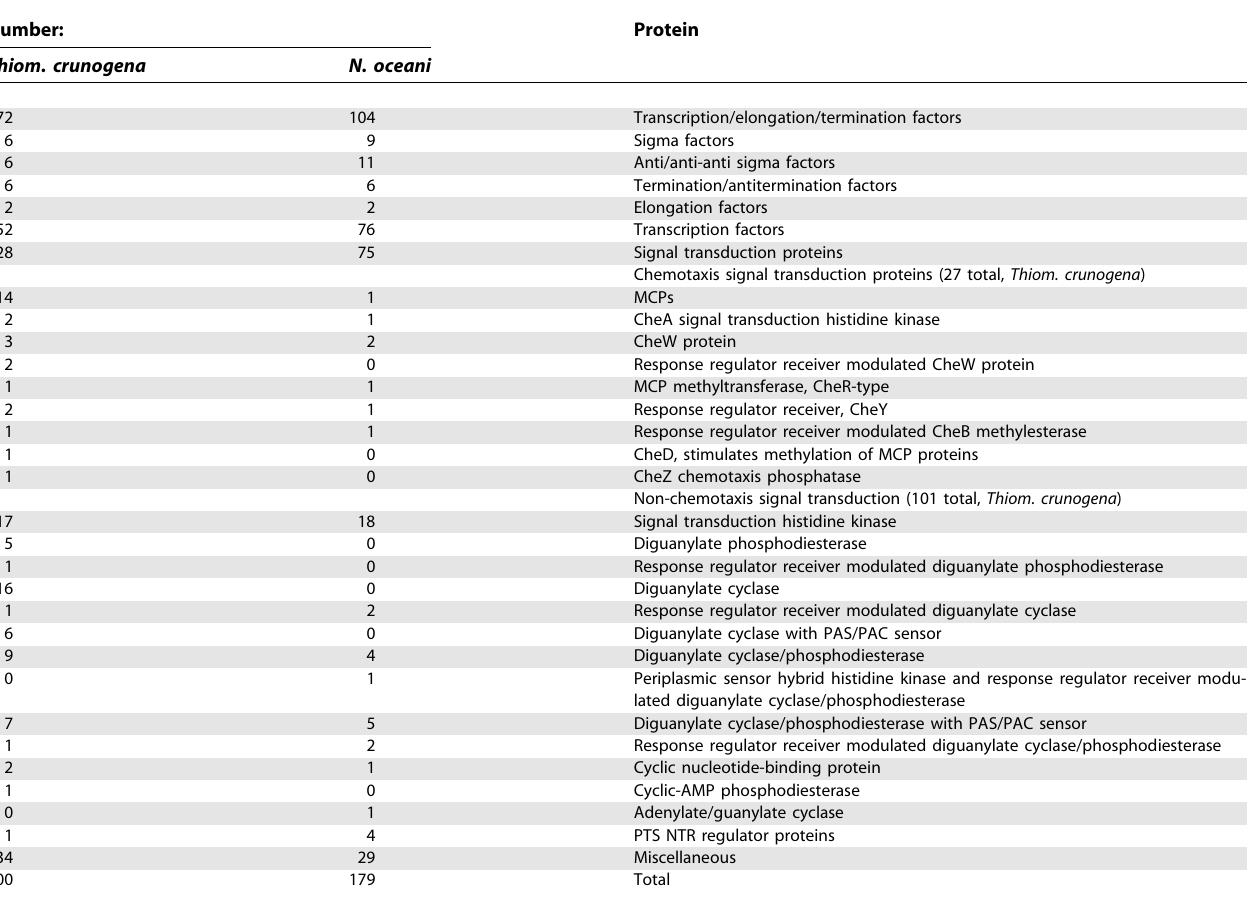
a A list of locus tags for these genes is present in Table S6. DOI: 10.1371/journal.pbio.0040383.t002